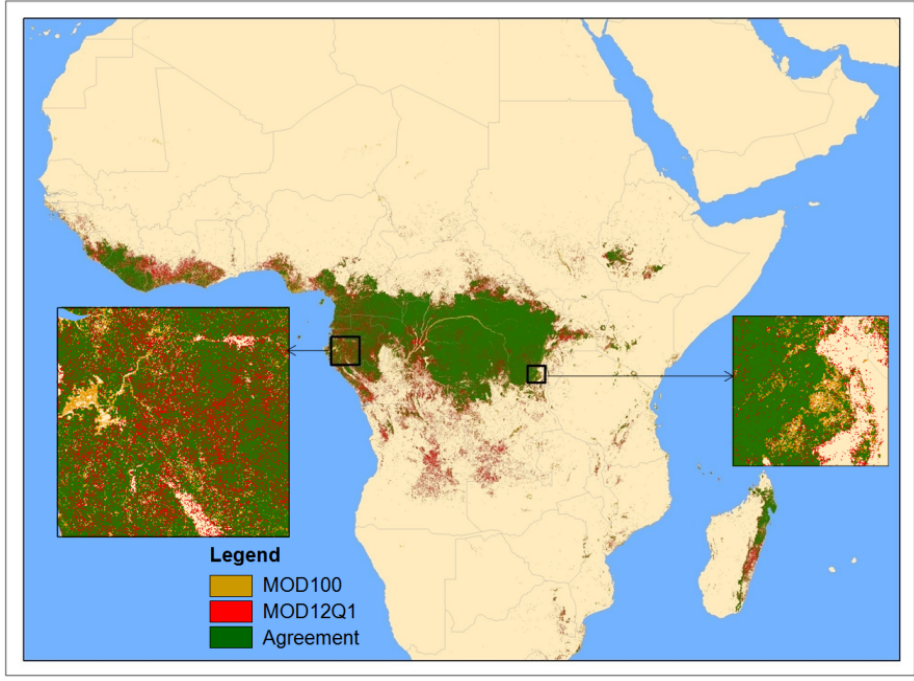
Figure 6. Spatial distribution of evergreen tropical forests in tropical Africa (30 ° N–30 ° S) in 2001 as estimated by the LSWI-based algorithm in this study (MOD100) in comparison to the MOD12Q1 dataset. In the figure legend, “Agreement” – evergreen forest pixels from both MOD100 and MOD12Q1; “MOD100” – evergreen forest pixel from MOD100 only; “MOD12Q1” – evergreen forest pixels from MOD12Q1 only. Two inserts in the figure shows a close-up comparison between these two datasets.